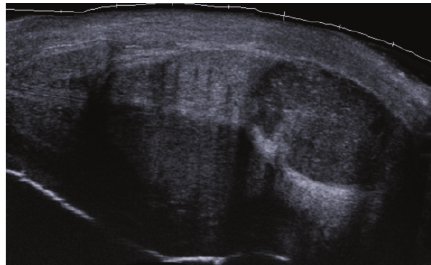
Figure 1: Longitudinal left of midline view of whole penis demon- strating clearly demarcated abscess within the proximal corpus cavernosum.